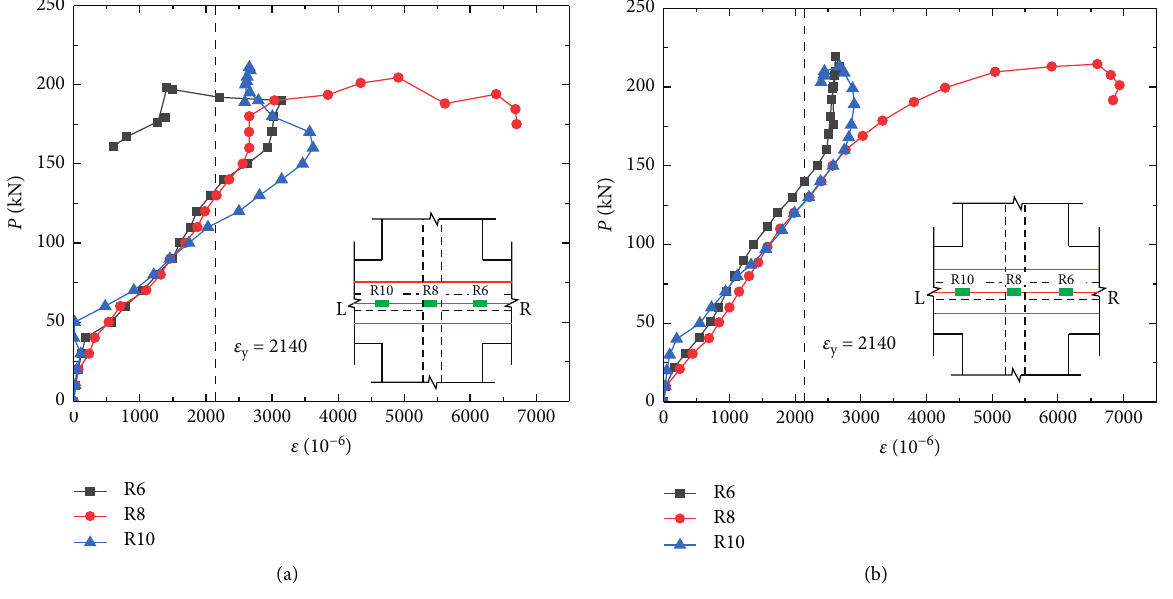
Figure 13: Load-tensile strain curves. (a) BGJ1 and (b)